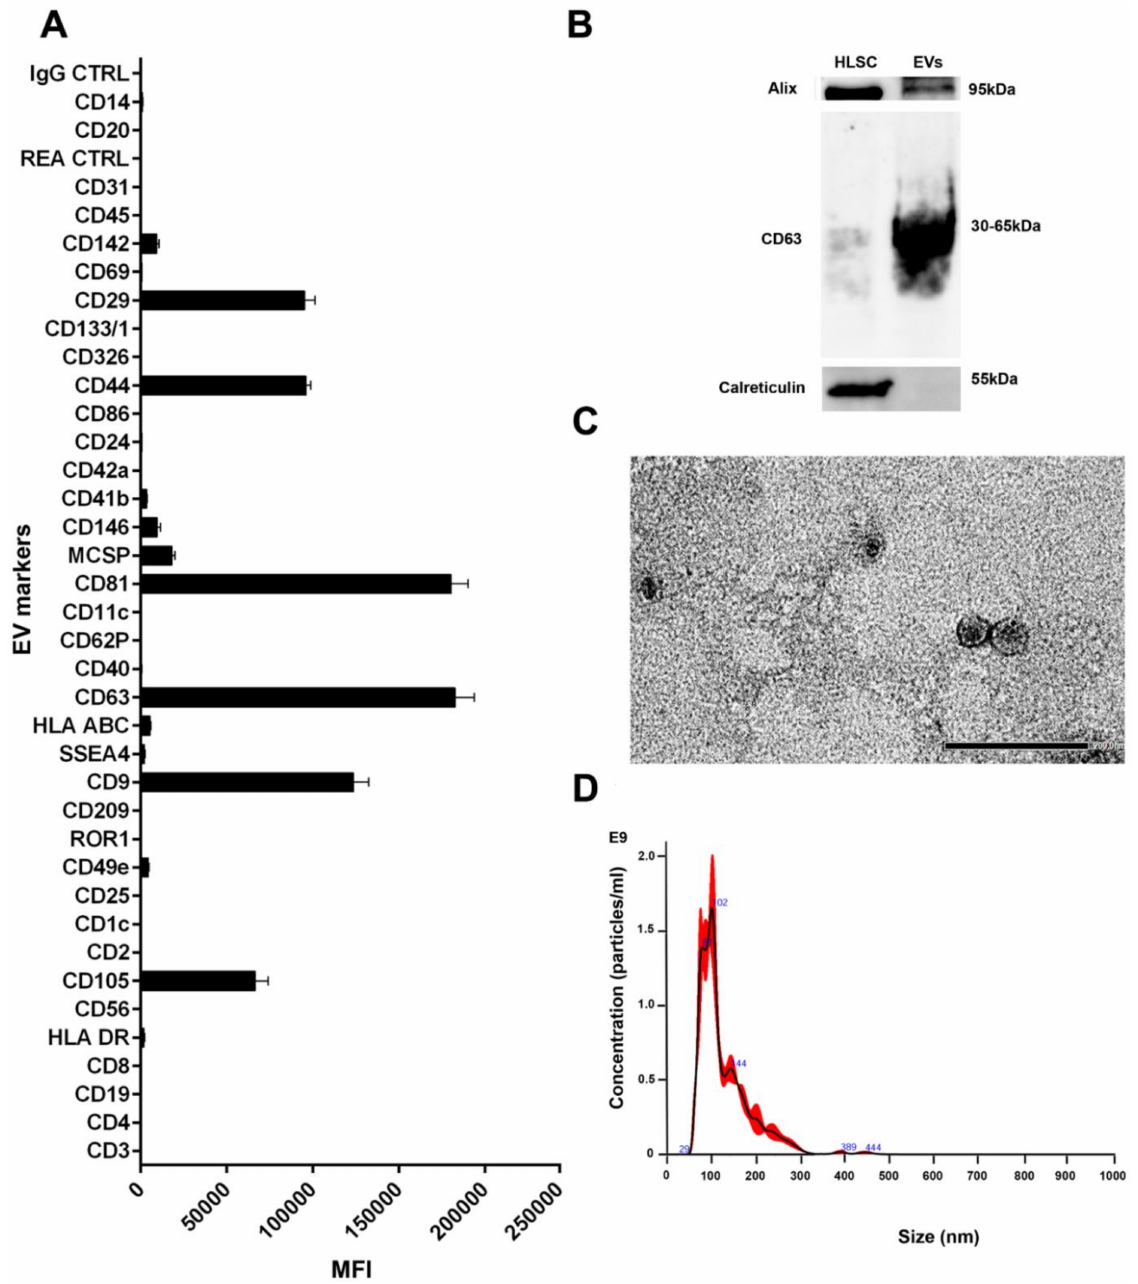
Figure 1. Characterisation of HLSC-EVs. ( A ) Characterisation of HLSC-EV surface antigens using a multiplex bead-based flow cytometry assay (n = 3 batches of HLSC-EVs, data represents mean ± SD). ( B ) Western blot analysis of HLSC- EVs displaying classical EV markers. ( C ) Representative electron microscopic images depicting HLSC-EV morphology (scale bar = 200 nm). ( D ) Nanoparticle tracking analysis showing the size distribution and concentration of